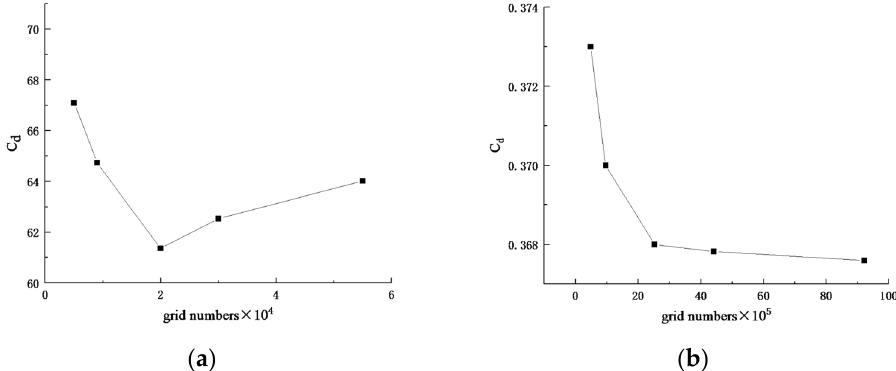
Figure 2. Grid independence test results. ( a ) Two-dimensional model grid independence test results; ( b ) three-dimensional model grid independence test results.